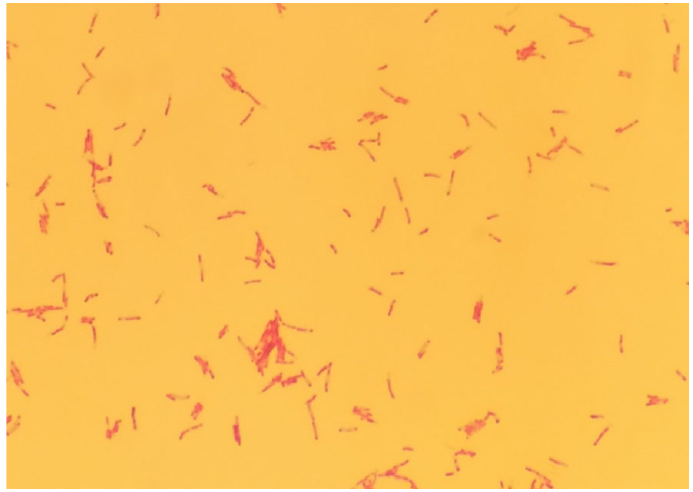
Figure 2. Acid ‐ fast rods (Ziehl ‐ Neelsen staining, ×1000) . Figure 2. Acid-fast rods (Ziehl-Neelsen staining, 1000 ×